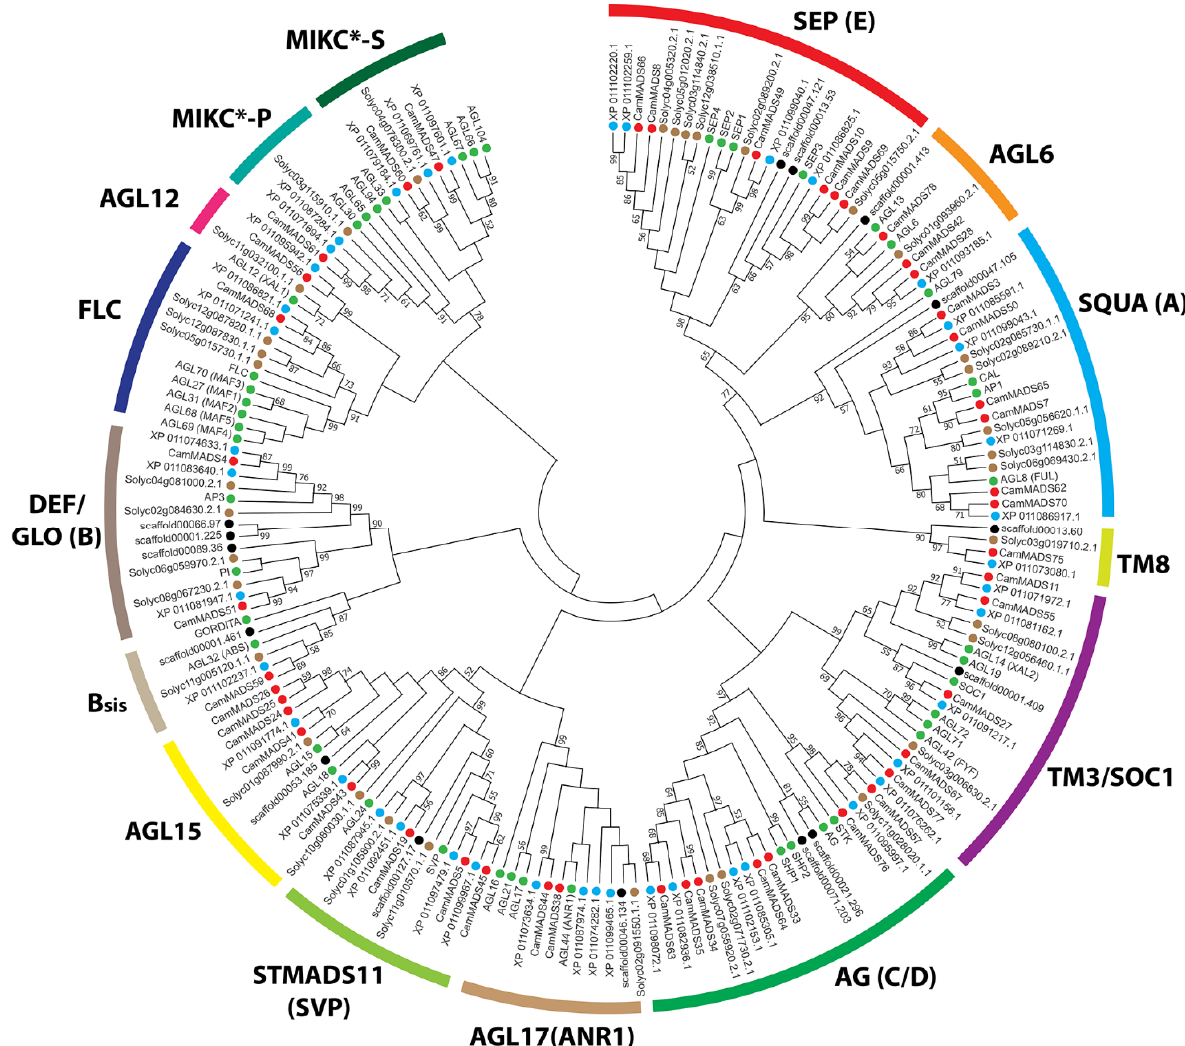
Figure 4. Maximum likelihood tree of type II MADS-box proteins in C. americana, A. thaliana, S. lycopersicum, S. indicum , and A. trichopoda . The MADS-box proteins contained in the branches for each species are indicated by different colored circles: red, C. americana ; green, A. thaliana ; brown, S. lycopersicum ; blue, S. indicum; black, A. trichopoda . For type II MADS-box proteins ML tree with branch length scale, see Supplementary Figure S2.